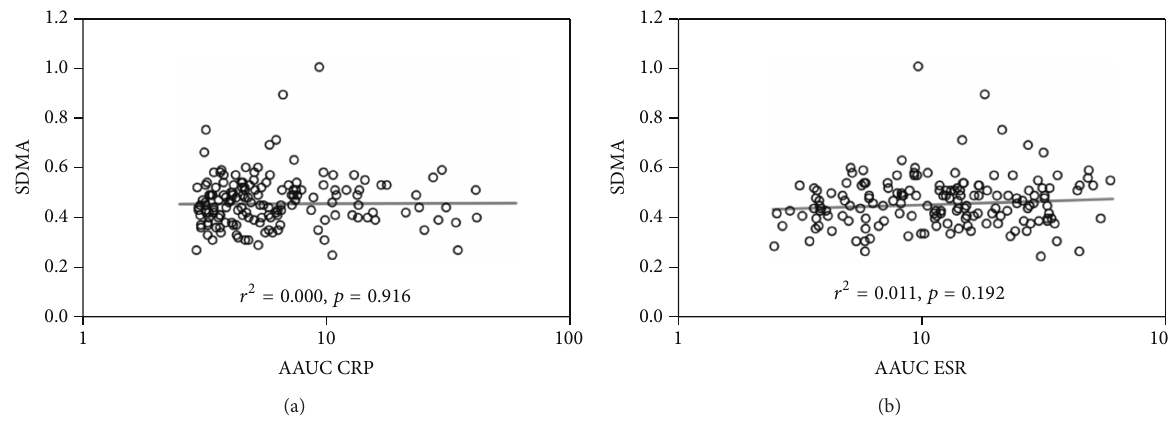
Figure 1: Graphic demonstration of the associations between SDMA and AAUCs of CRP (a) and ESR (b). Cumulative inflammation is plotted on a logarithmic scale, and the fit line and related statistics are based on the regression models in Table 2. SDMA: symmetric dimethylarginine, ESR: erythrocyte sedimentation rate, CRP: C-reactive protein, and AAUC: average area under the